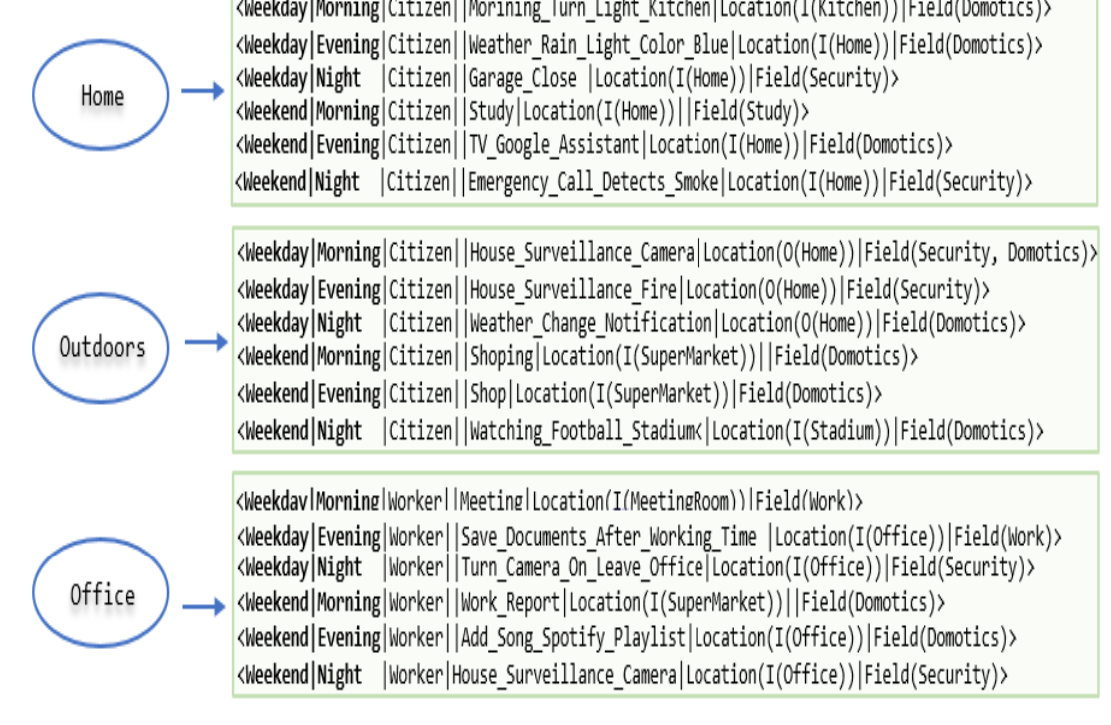
Figure 12. An example of a user rules repository in three user’s domains.